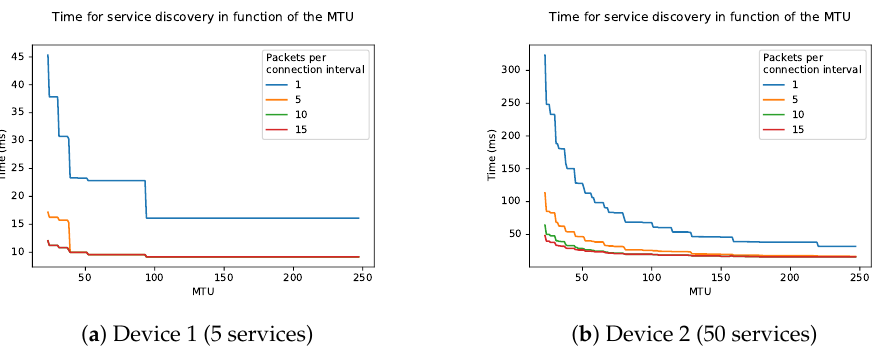
Figure 18. Time of the RSDP as a function of the MTU of two devices: ( a ) Device 1 and ( b ) Device 2 with a limitation on packets per connection interval.